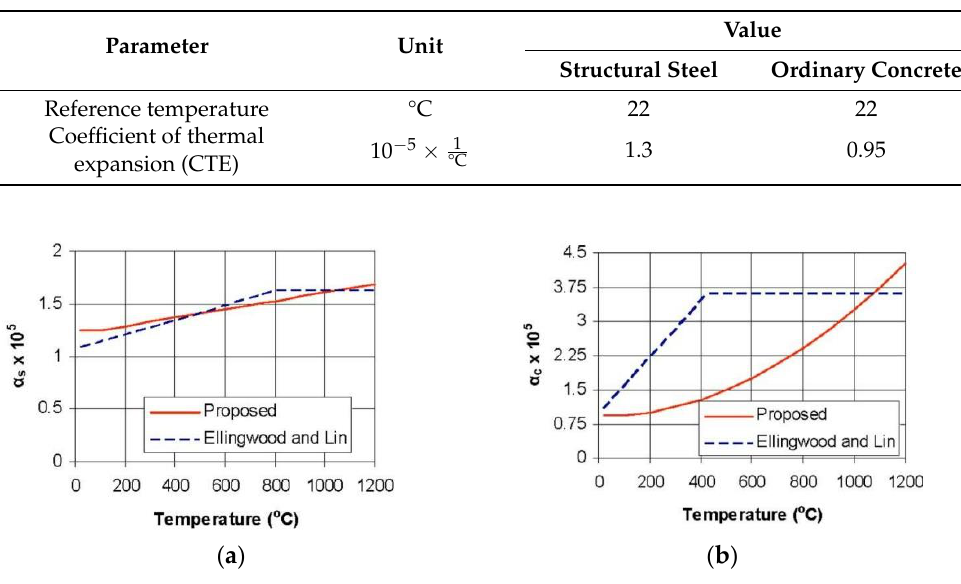
Figure 2. Temperature-dependent coefficient of thermal expansion for different materials used in the present study, including ( a ) structural steel and ( b ) ordinary concrete [49].